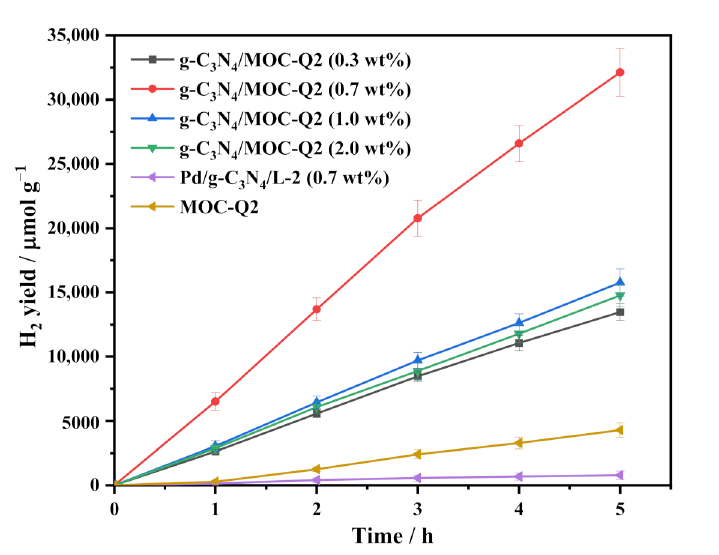
Figure 5. Photocatalytic H 2 evolution of MOC-Q2, Pd/g-C 3 N 4 /L-2 (0.7 wt%), and g-C 3 N 4 /MOC-Q2 (0.3/0.7/1.0/2.0 wt%) under visible light irradiation.